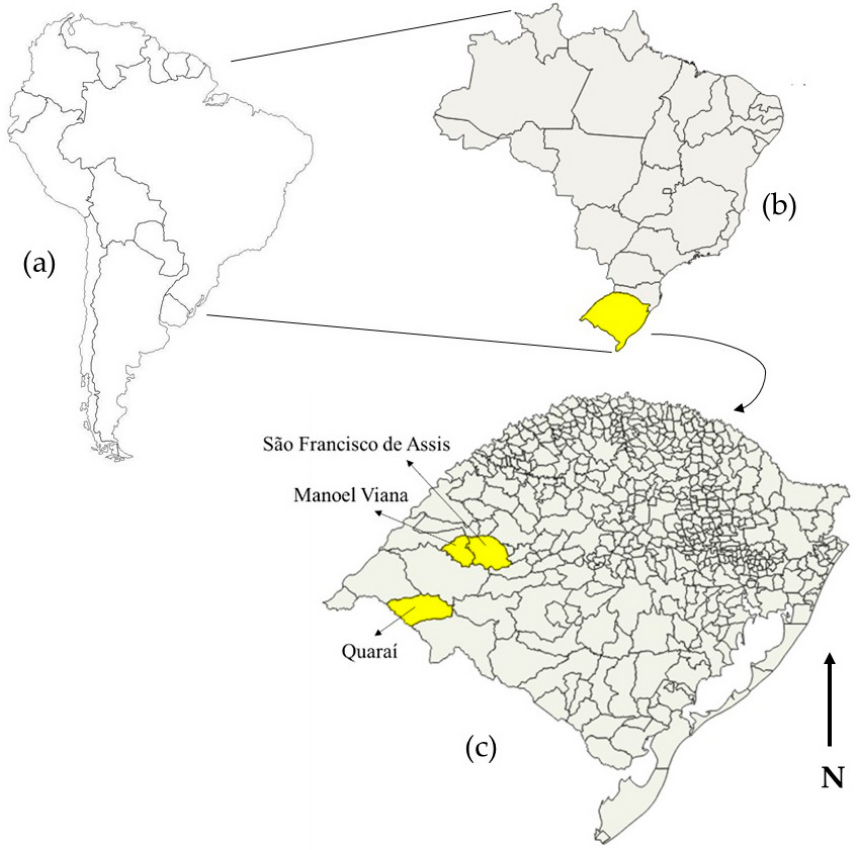
Figure 1. Map without scale from South America ( a ) Brazil and Rio Grande do Sul State highlighted (yellow) ( b ) and the cities of Quaraí (latitude 30°23 ′ 17 ″ S; longitude 56°29 ′ 56 ″ W; 112 m mean altitude; area ≅ 3238 km²), Manoel Viana (latitude 29°35 ′ 07 ″ S; longitude 55°29 ′ 13 ″ W; 113 m mean altitude; area ≅ 1391 km²), and São Francisco de Assis (latitude 29°33 ′ 01” S; longitude 55°07 ′ 52 ″ W; 125 m mean altitude; area ≅ 2507 km²), Rio Grande do Sul State ( c ).